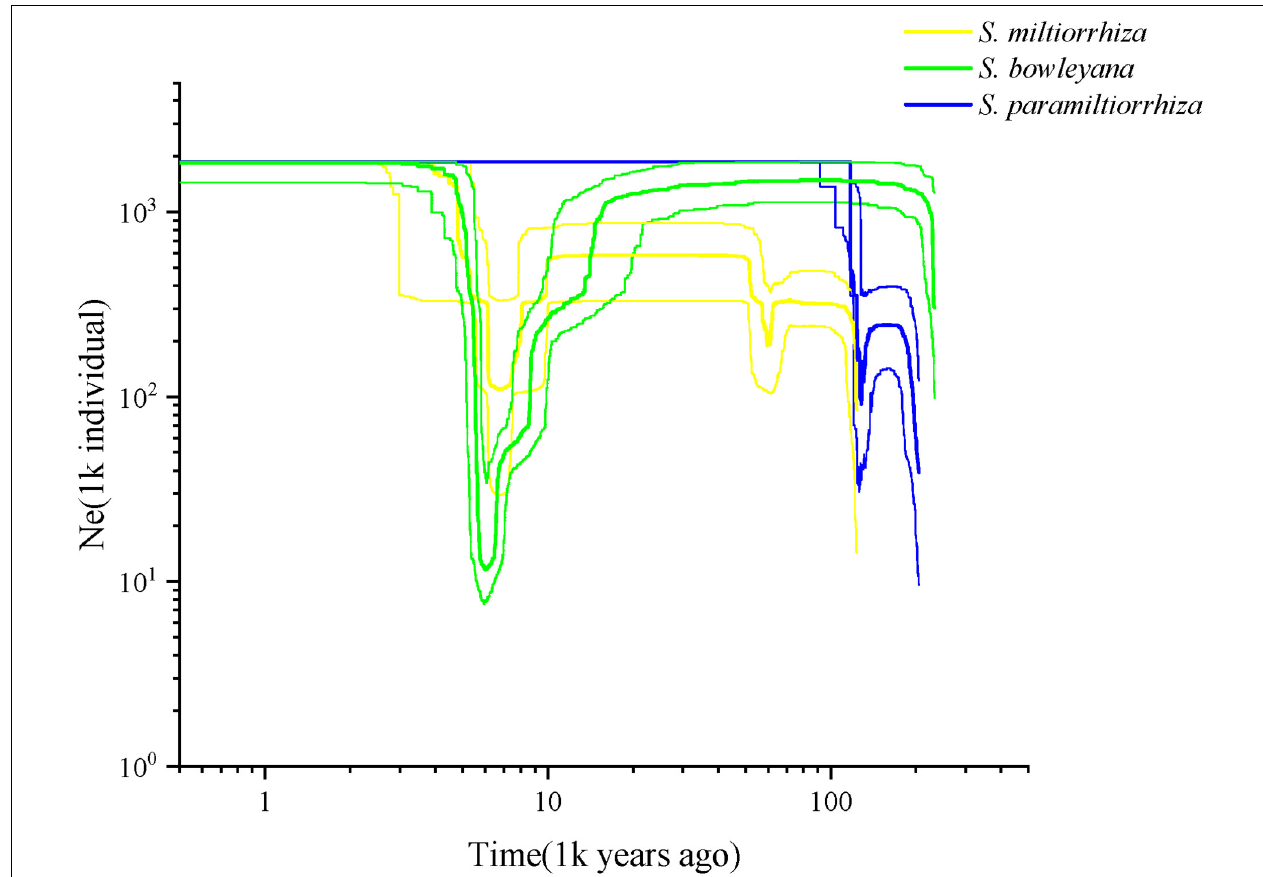
FIGURE 6 | Reconstructed demographic history of S. miltiorrhiza (yellow), S. bowleyana (green), and S. paramiltiorrhiza (blue). Stairway plot showing historical changes in effective population size for three species population with generation time of 1